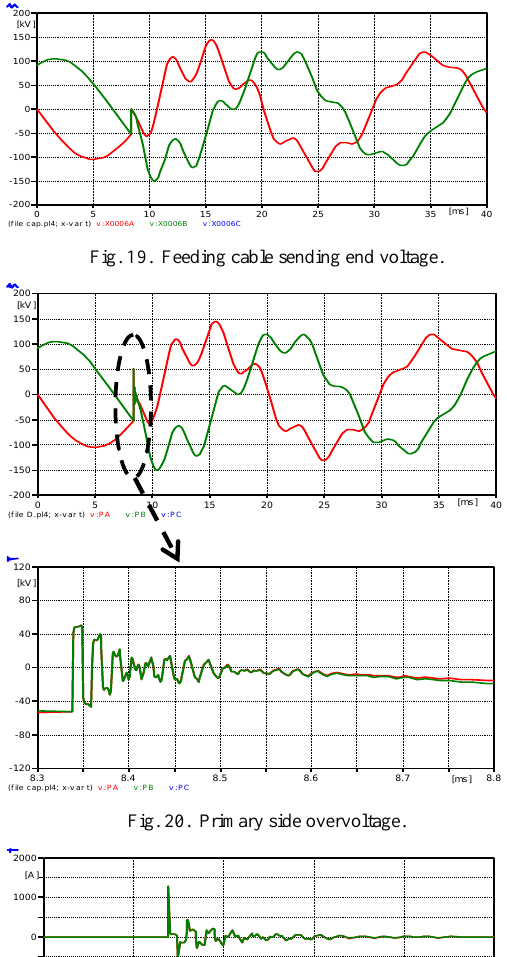
Fig. 21. Zoomed primary side current.